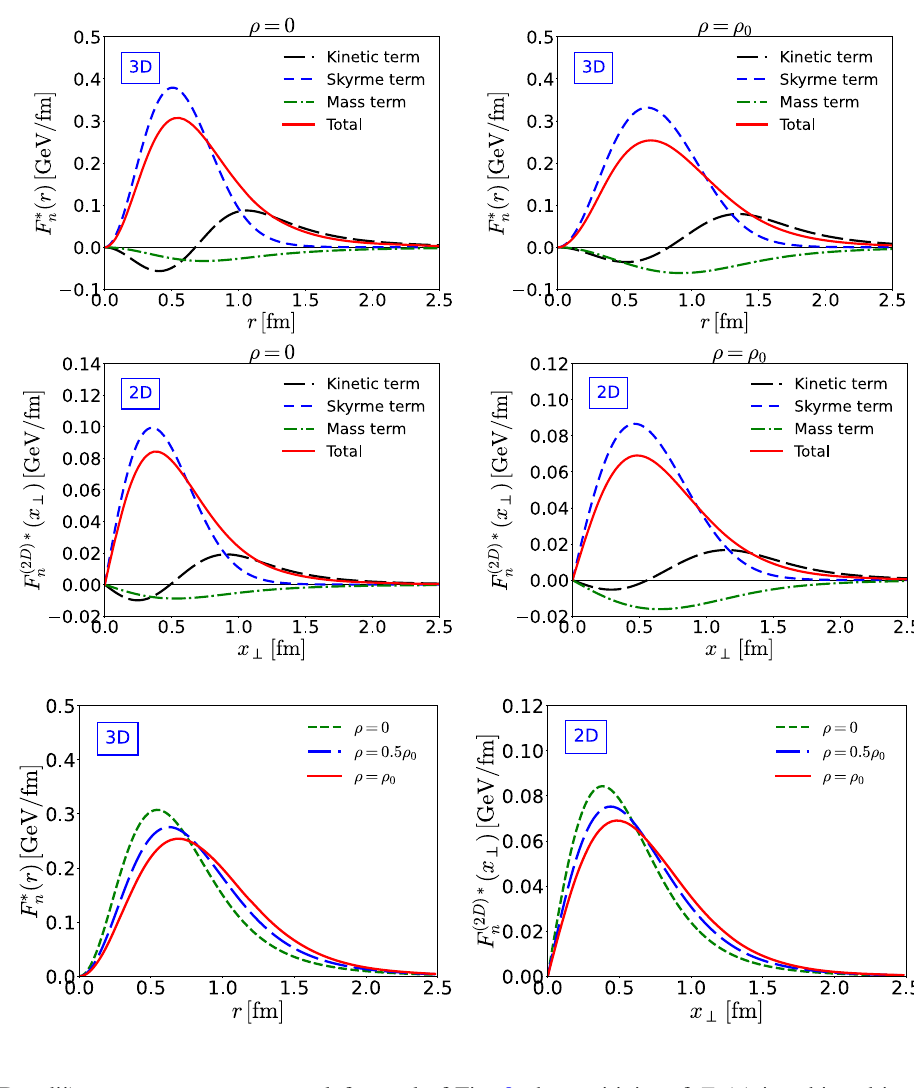
(cid:3) x 2 (cid:4) E < (cid:3) x 2 ⊥